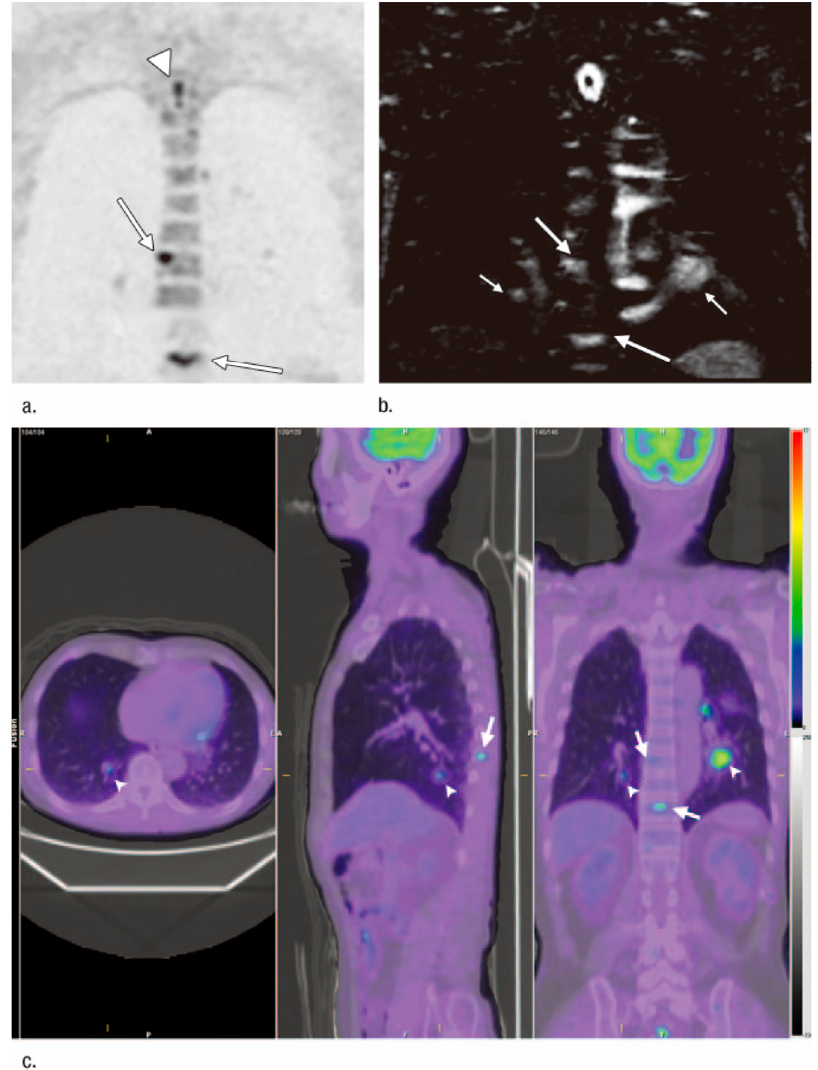
Figure 5. Images of 74-year-old man with adenocarcinoma, lung metastases, and bone metastases (permission obtained from reference #52). ( a ) Whole-body DW image (5759/70/180) in coronal plane shows bone metastases with a score of 5 for high signal intensity (arrows). However, the normal spinal cord also shows high signal intensity (arrowhead) and also received a score of 5. No lung metastases within either lung could be detected, and as these metastases were contained, they were scored as 1. Although this was a true-positive case, there were two false-negative sites and one false- positive site. ( b ) STIR image (3200/60/150) in coronal plane shows lung metastases (small arrows) and bone metastases (large arrows) as having high signal intensity, scored as 4 and 5, respectively. This was diagnosed as a true-positive case on whole-body MRI with and without DWI. ( c ) Inte- grated FDG-PET/CT images demonstrate bilateral lung metastases (arrowheads) and bone metasta- ses (arrows), both of which were scored as 5. This was diagnosed as a true-positive case on inte- grated FDGPET/CT. Colored bar: standardized uptake value; gray bar: Hounsfield units. 4. Conclusions To provide an update on the most recent advancements in the field of lung cancer TNM stage evaluation, we reviewed state-of-the-art MRI currently used for dedicated chest MRI, whole-body MRI, or PET/MRI. Following the implementation of fast imaging and the technical improvements of gradients and coil systems, MRI is now capable of providing unprecedented contrast with the aid of recently developed sequences, with and without contrast media, and using quantitative and qualitative analysis for thoracic on- cology.